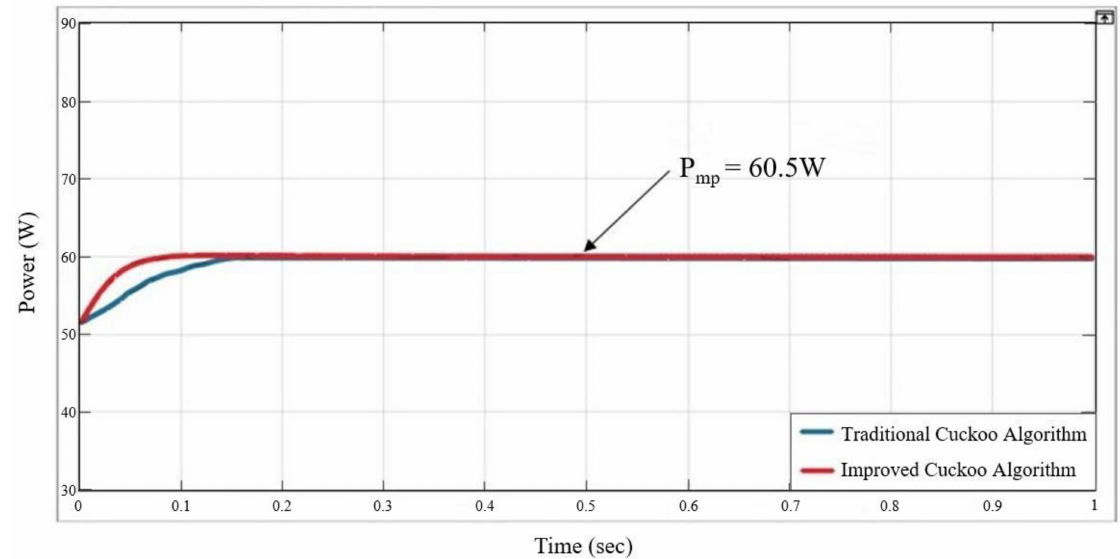
Figure 7. Simulation result of maximum power point tracking of traditional and improved cuckoo algorithm in Case